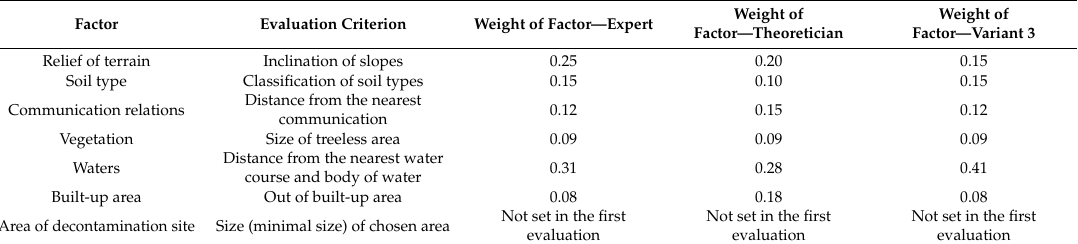
Table 8. Weights of factors and evaluation criteria—experts and